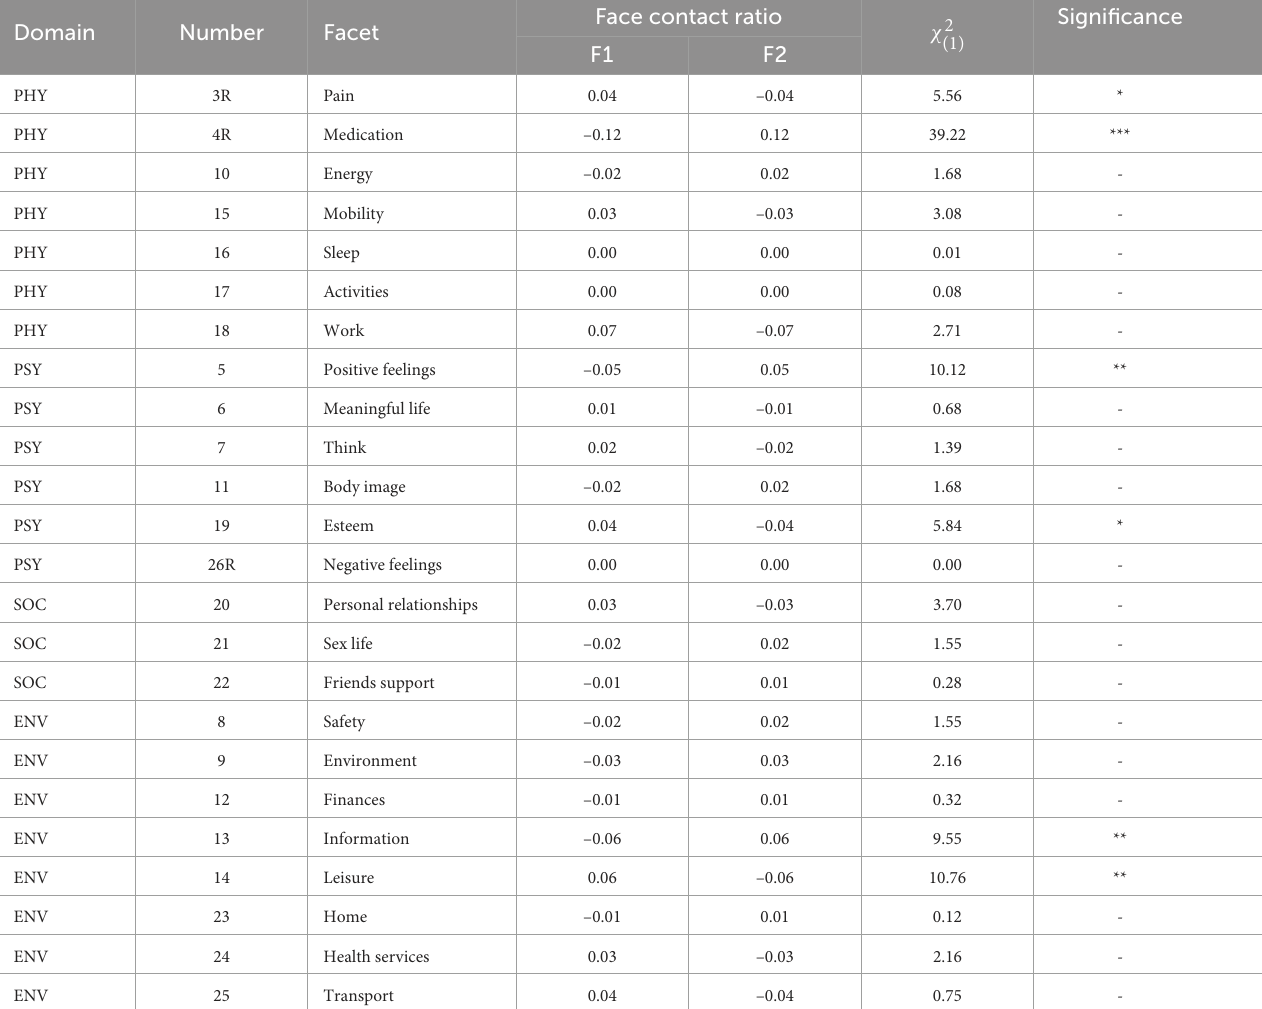
TABLE 5 Summary table for the DIF analysis in the items of the WHOQOL-BREF across subgroups of the face-to-face contact ratio.